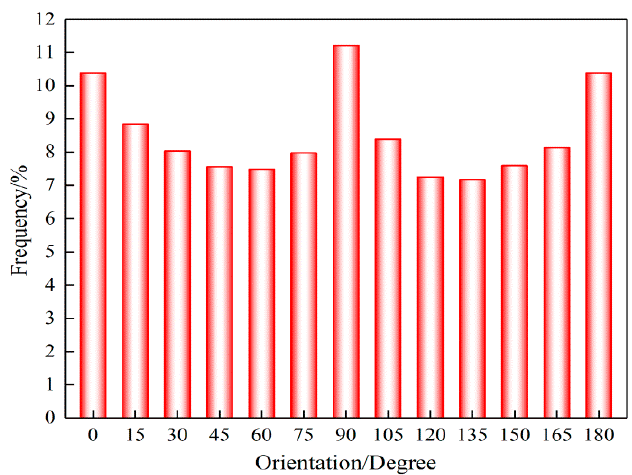
Figure 7. Fiber orientation distribution (FOD) in SF/PCL nanofibrous mats.